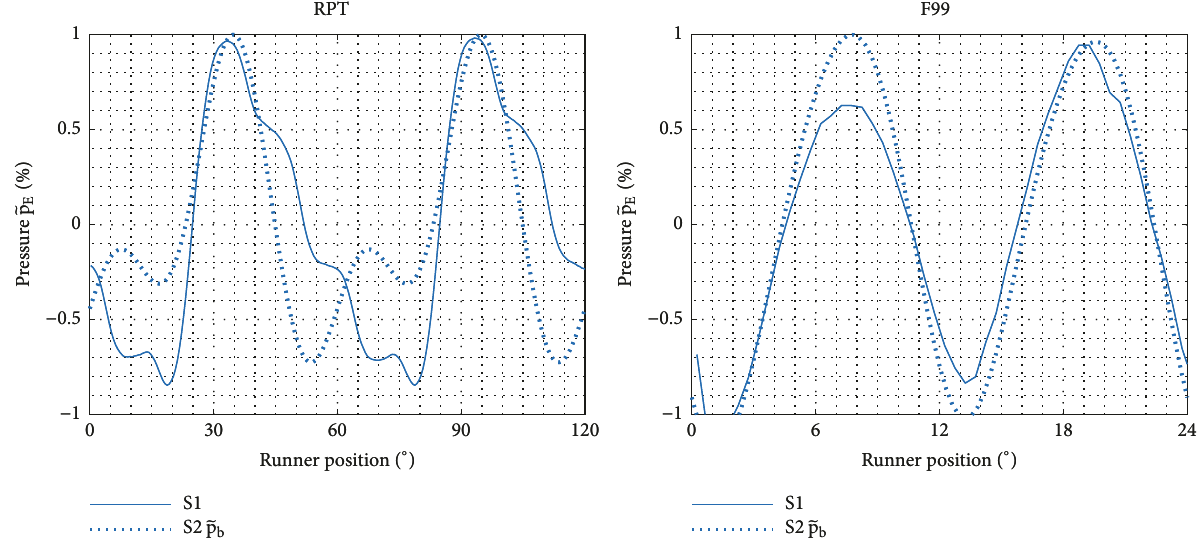
Figure 12: Comparison of the calculated throttling pressure and the measurements with sensor S1. All pressure values were normalized to signal